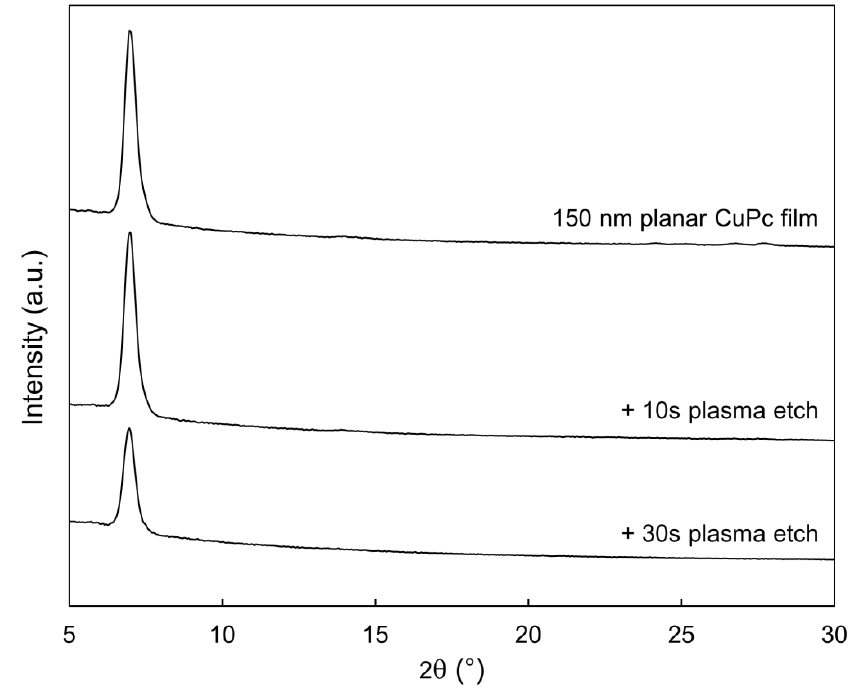
Figure 9. Changes to the XRD spectrum of a planar CuPc thin film as a result of 220 W argon plasma